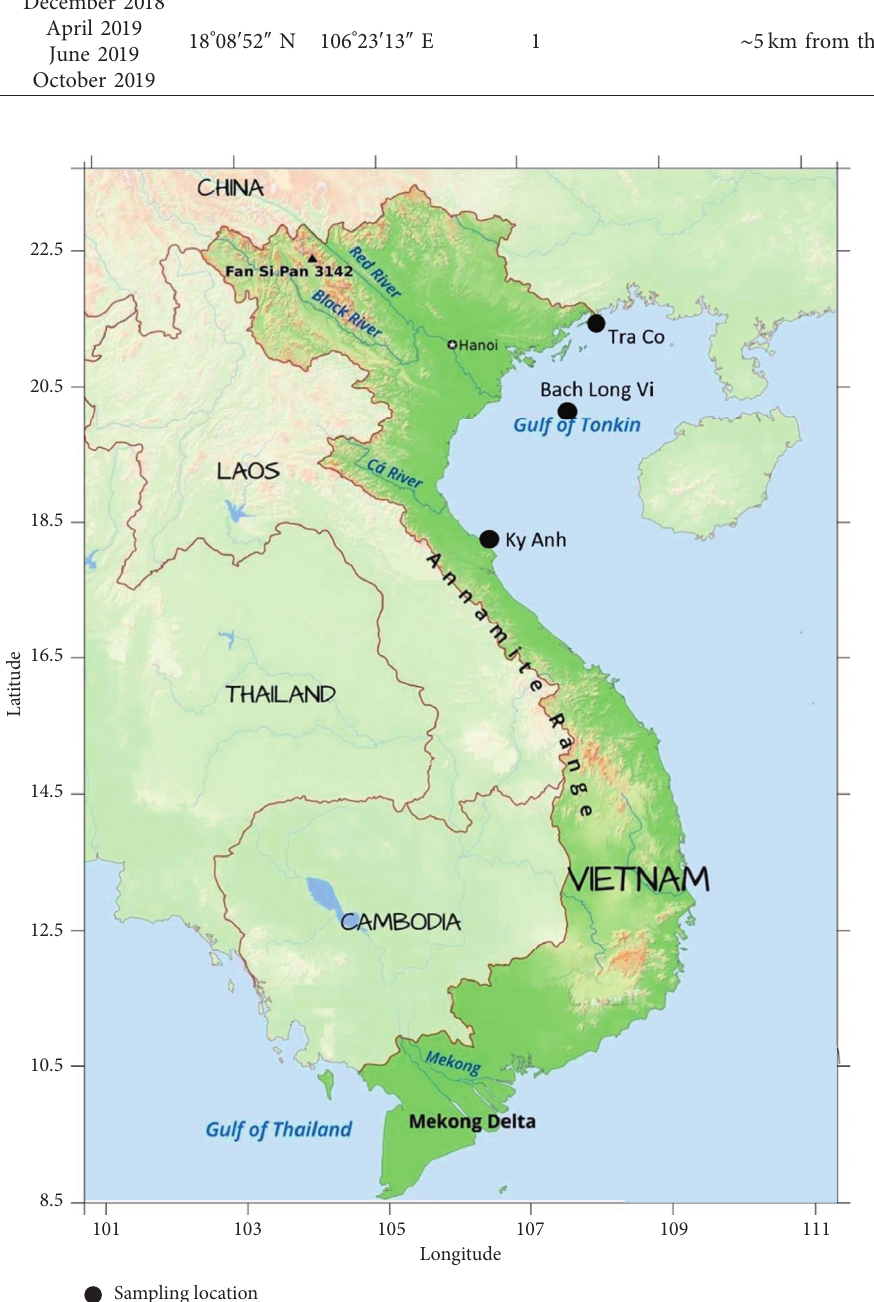
Figure 1: Sampling locations in the Gulf of